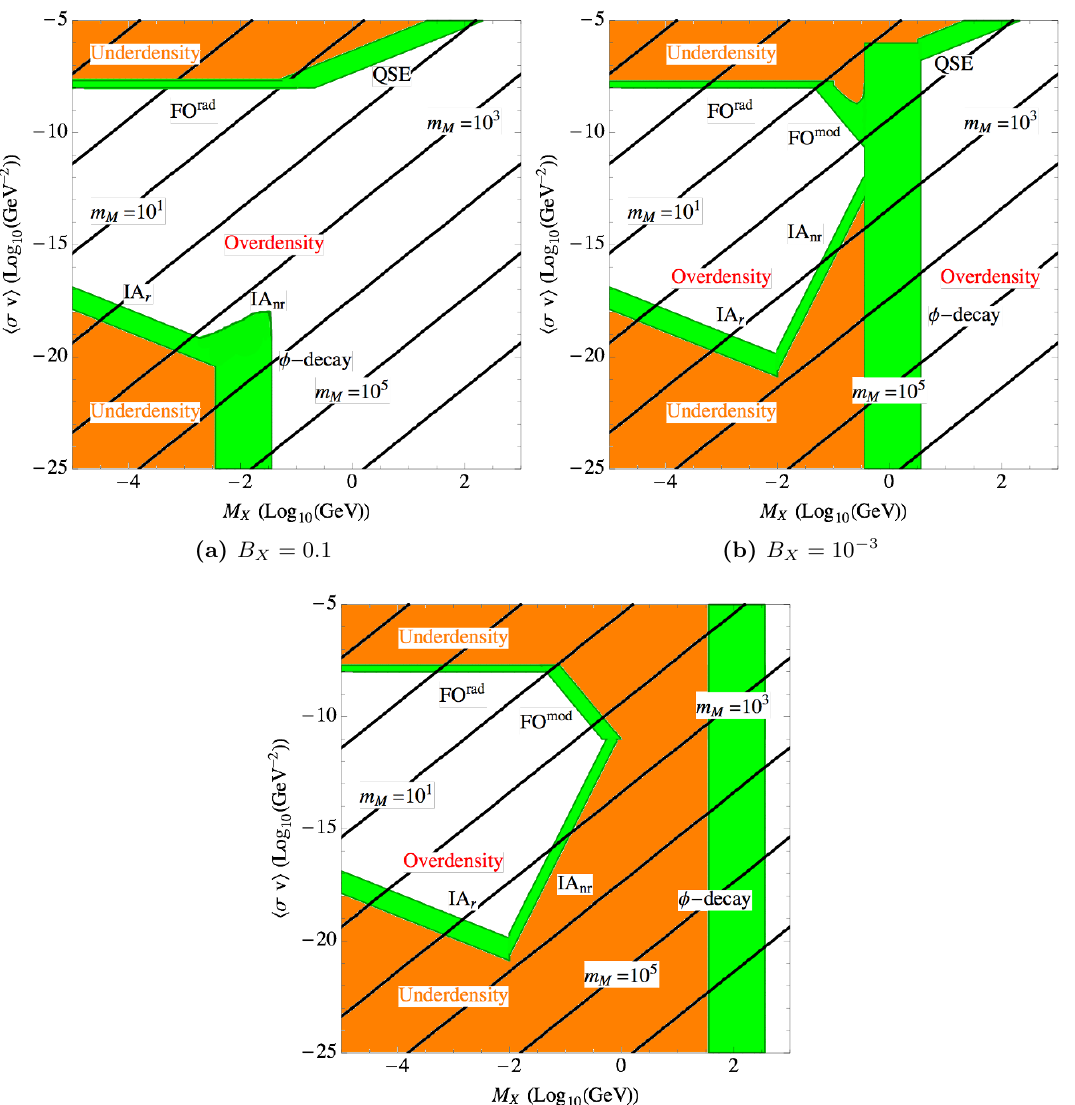
2 0 : 12, while in X h (cid:20) GeV, calculated using the approximate (cid:2) g H ). All /